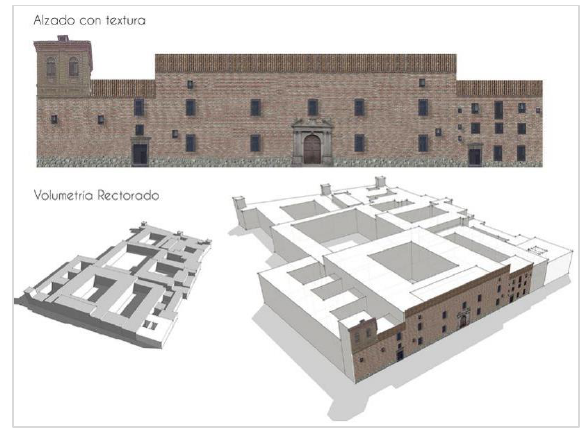
Figure 5. AR Drawings. Elevations and volumetry. Façade Alcalá de Henares